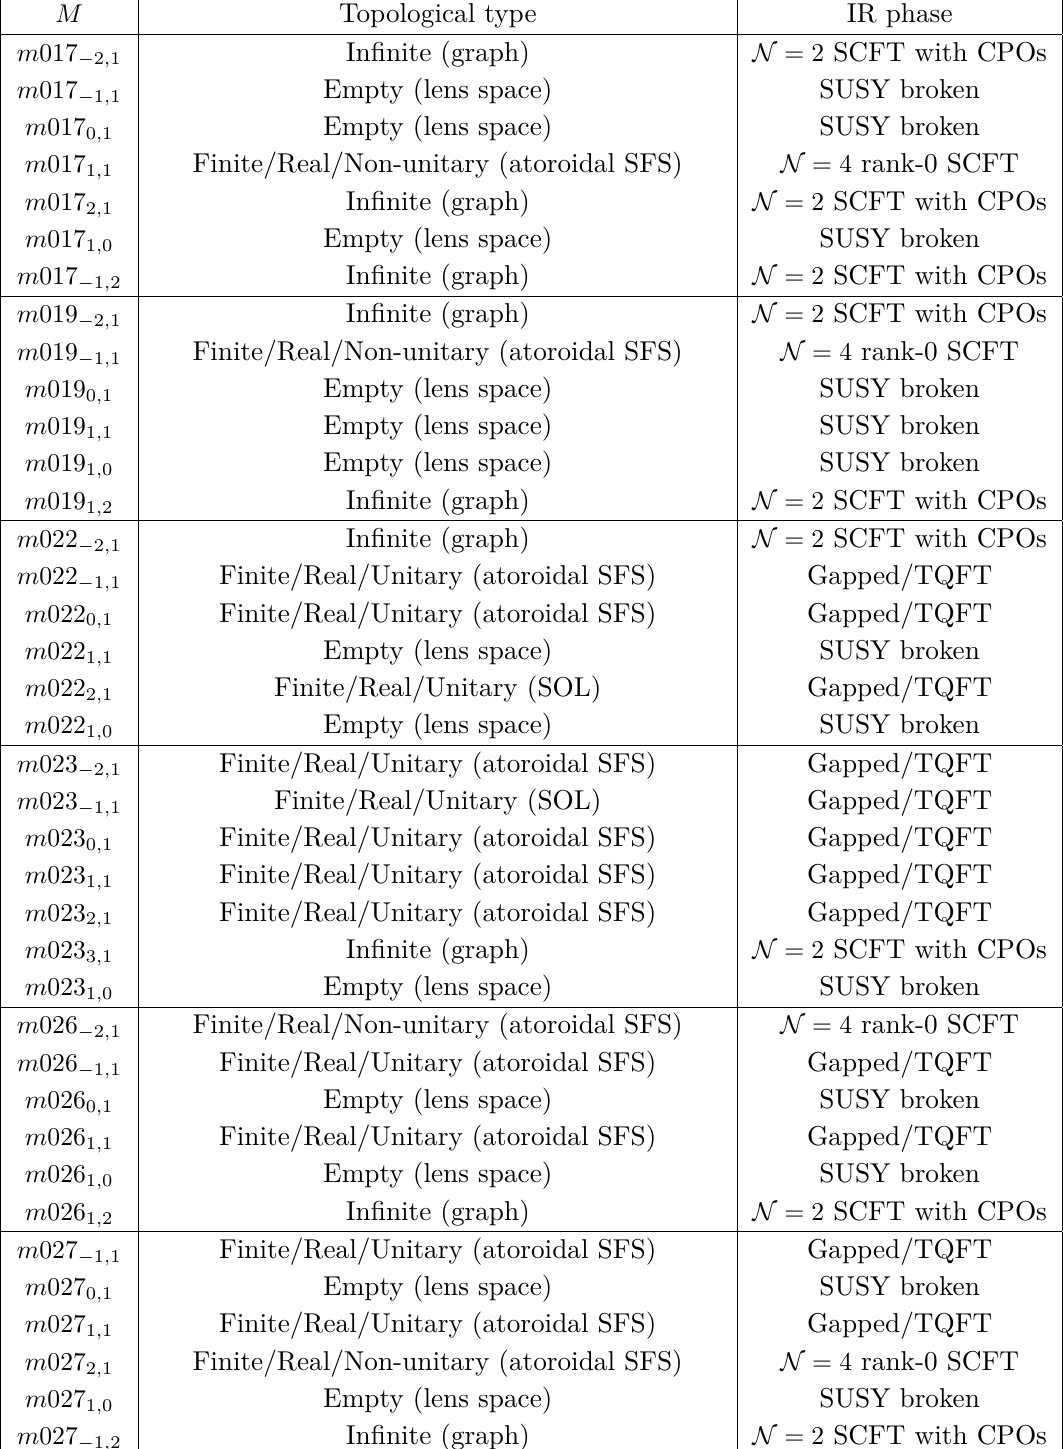
Table 3. Topological types of non-hyperbolic 3-manifolds obtained by exceptional Dehn fillings and the IR phases for the associated class R theories. Here N . Refer to [8] for the topological types of the non-hyperbolic 3-manifolds in the N PA SP + QB SP conventional mathematical classification scheme ( continues